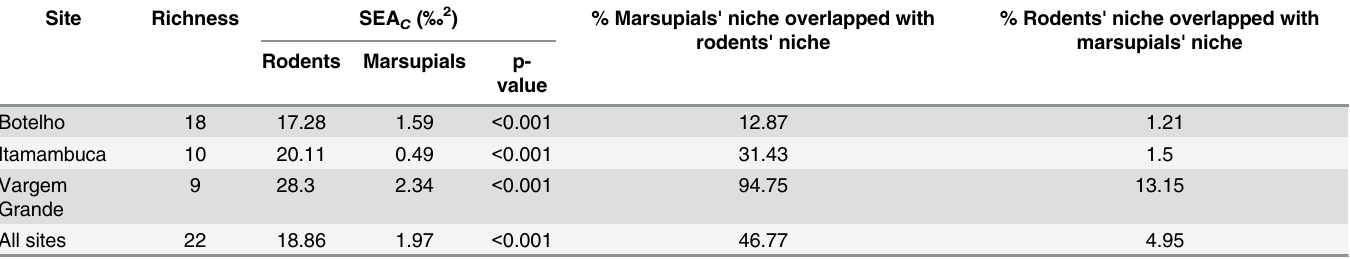
Table 2. Richness, comparison between the areas of the isotopic niche space (SEA C ) occupied by rodents vs. marsupials, and percentage of the niche overlapped with the other group for marsupials and rodents in three sites of the Atlantic